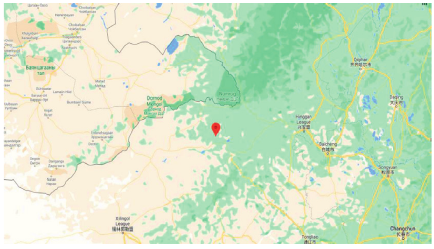
Figure 1: Mine location